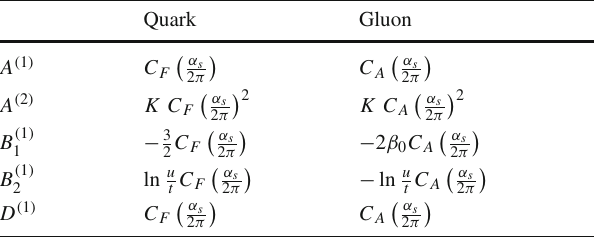
Table 1 Perturbative coefficients for the Sudakov integral, where one sums the A and B factor for incoming parton species, and choose D for the corresponding jet species Quark Gluon